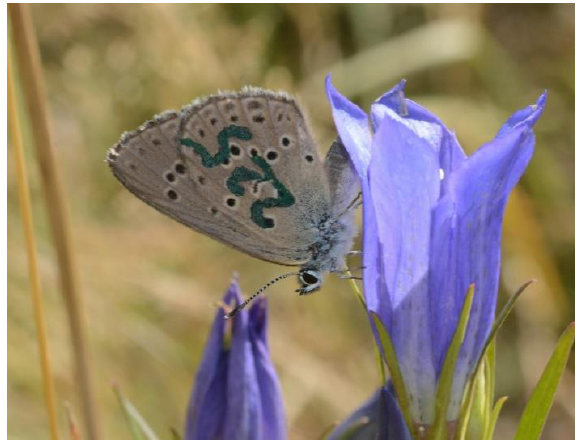
Figure 3. A marked individual of Phengaris alcon on a flower of Gentiana pneumonanthe.